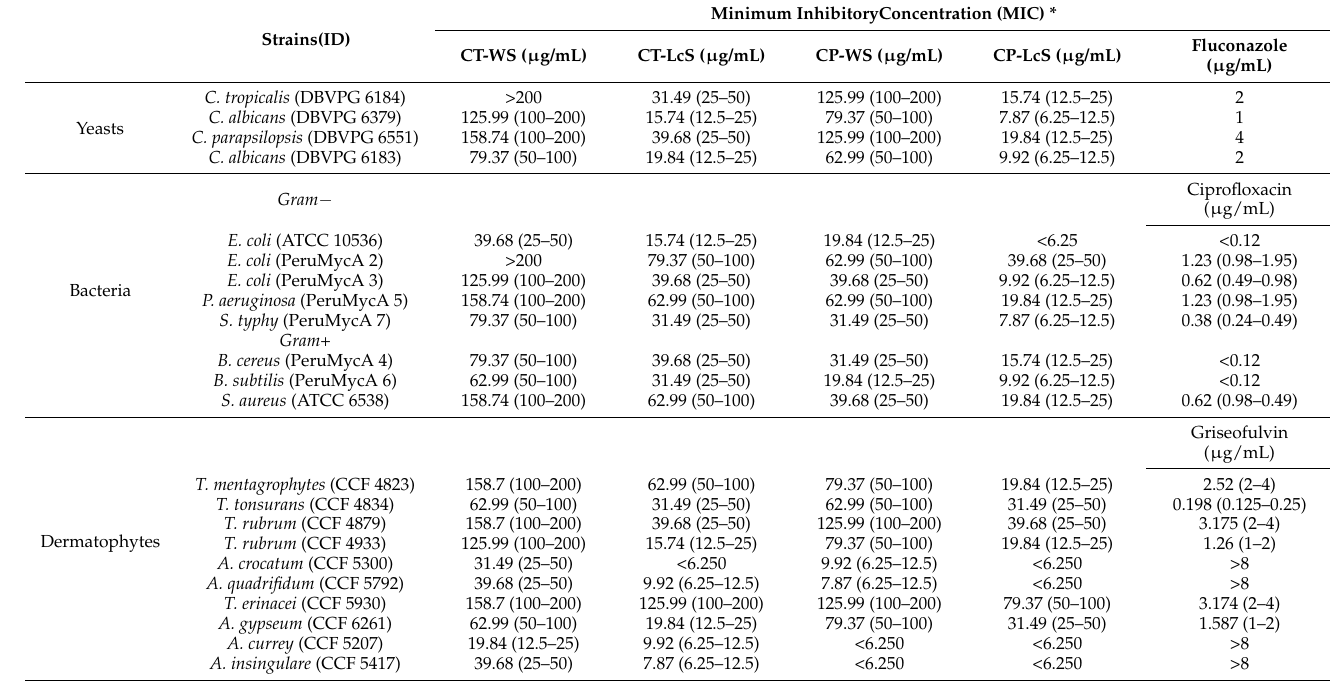
Table 4. MIC of P. ostreatus extracts against yeast, bacterial and dermatophytes